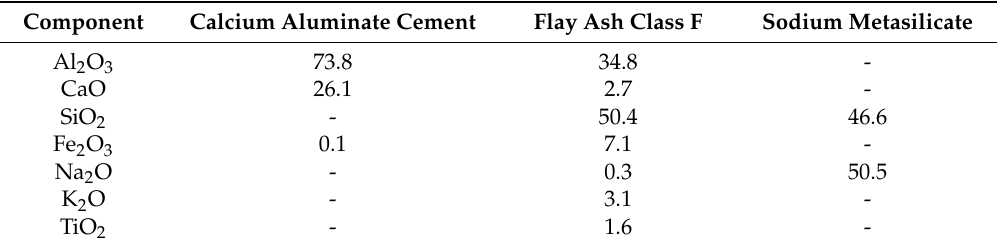
Table 1. The elemental composition of Thermal Shock Resistant Cement components. Component Calcium Aluminate